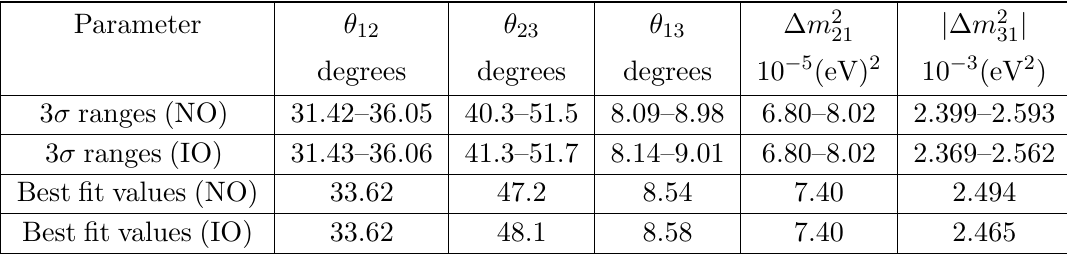
Table 1 . Input values used in the analysis [3].